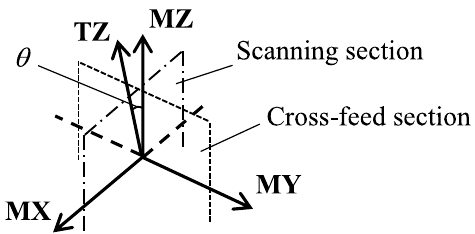
Fig. 2. Two instantaneous sections and tool inclination angle u between MZ and